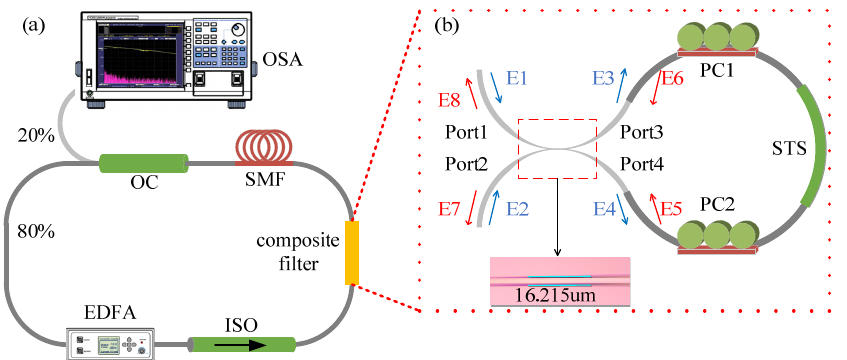
Figure 1. ( a ) Schematic diagram of the proposed fiber laser based on composite filter. ( b ) The schematic diagram of the composite filter. EDFA: erbium-doped fiber amplifier, ISO: isolator, SMF: single mode fiber, OC: 20:80 output coupler, PC1 and PC2: polarization controllers, STS: SMF-TMF- SMF, TMF: two mode fiber.